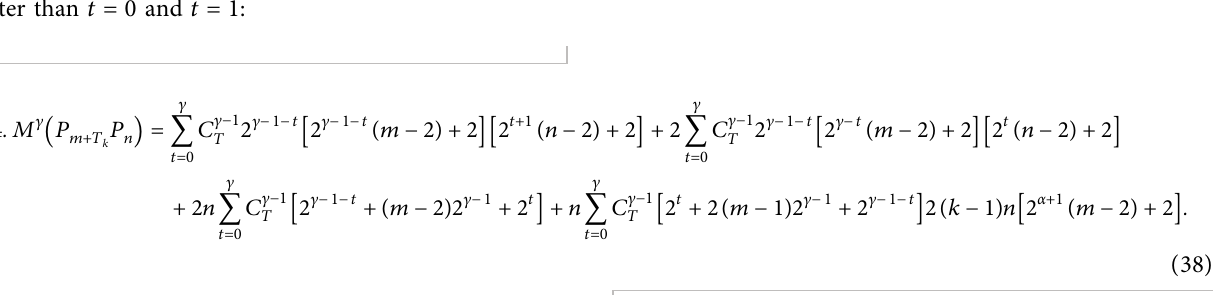
Figure 7: Numerical behavior of M c ( P